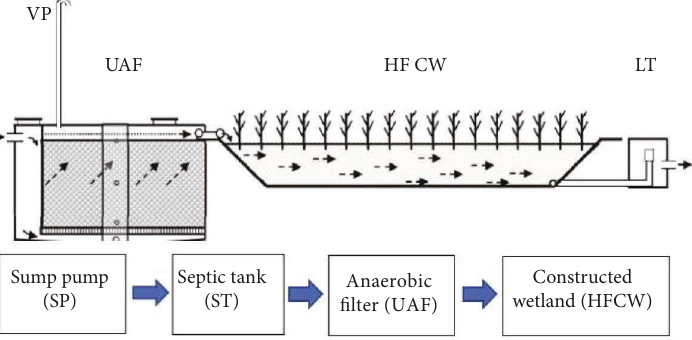
Figure 1: Important parts of the wastewater treatment process: vent pipe (VP), up-flow anaerobic filter (UAF), horizontal subsurface flow constructed wetland (HFCW), and level tank (LT)